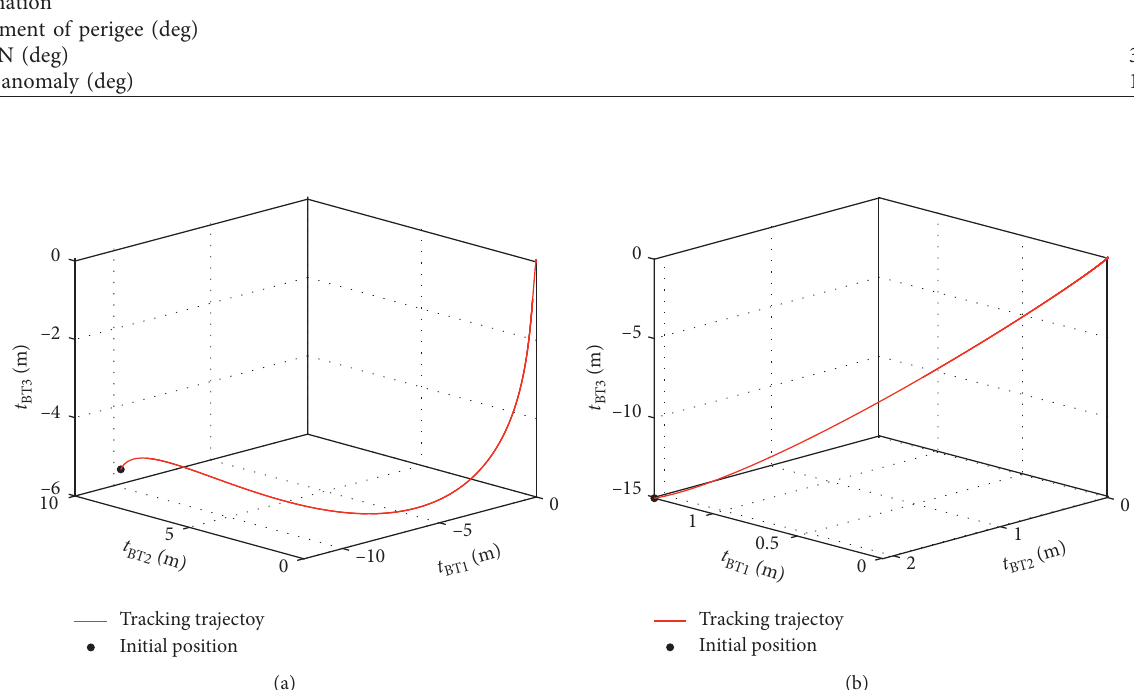
Figure 1: Global result of the tracking trajectory. (a) Observed in the chaser body fixed frame. (b) Observed in the target body fixed